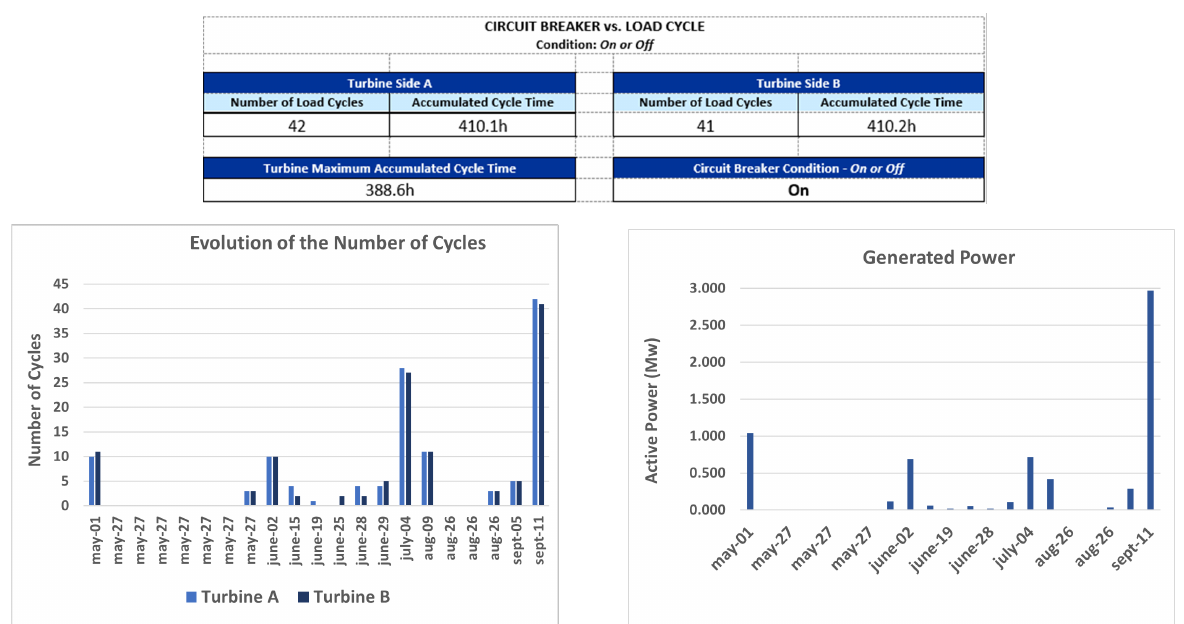
Figure 3. Turbine Load Cycle—General Dashboard for a